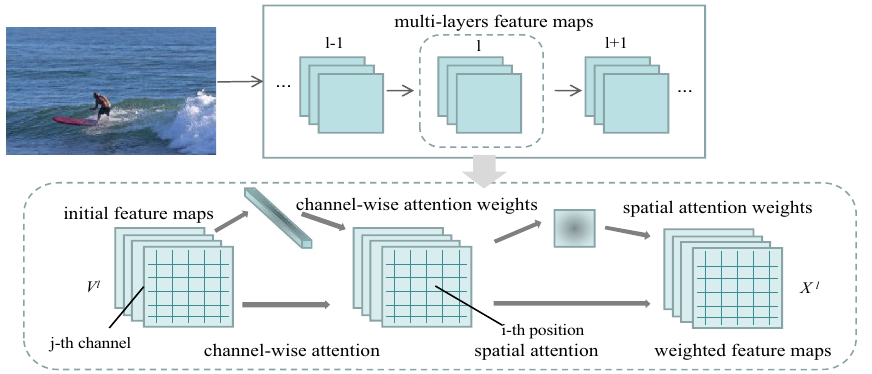
Figure 2. Overview of channel-wise and spatial